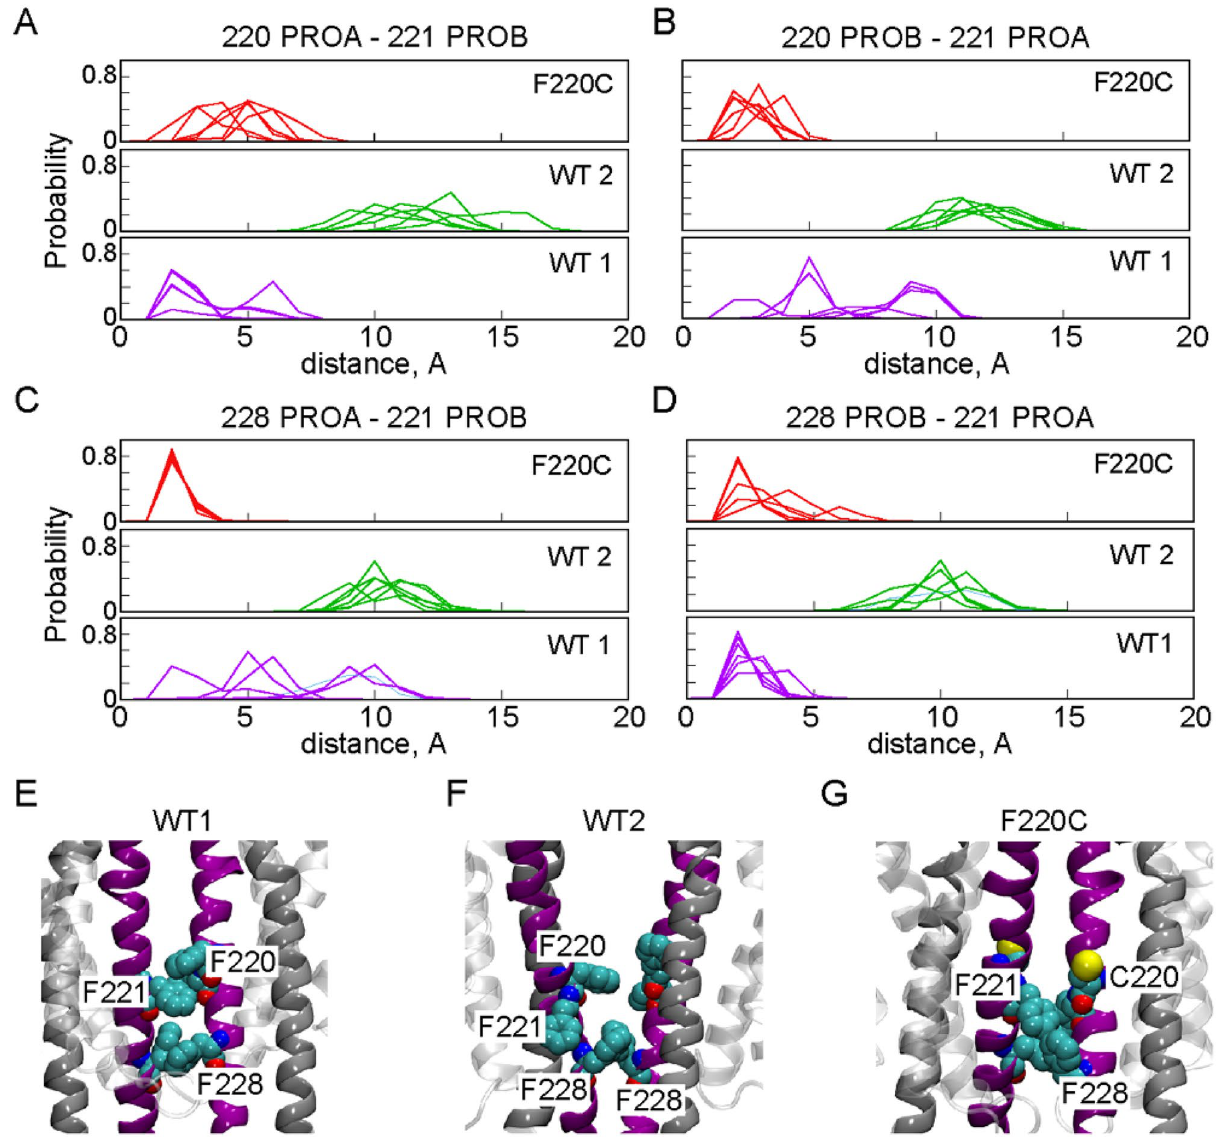
Figure 8. ( A,B ) Probability distribution of the minimum distance between residues F/C220 5.55 and F221 5.56 on the opposite monomers of dimers formed by WT opsin (Modes 1 and 2—WT1, WT2) and F220C. ( C,D ) Probability distribution of the minimum distance between residues F228 5.63 and F221 5.56 on the opposite monomers of dimers formed by WT opsin (Modes 1 and 2—WT1, WT2) and the F220C mutant. PROA (A,C) and PROB (B,D) denote two monomers of the dimer, and the results are shown separately for all six replicates for each construct. ( E–G ) Close-up view of molecular interactions along TM5 helix in the F220C dimer (G) and in the Mode 1 and Mode 2 WT dimers ( E,F respectively). Relevant residues are shown in space-fill and labeled. TM5 and TM6 helices are shown in purple and silver,